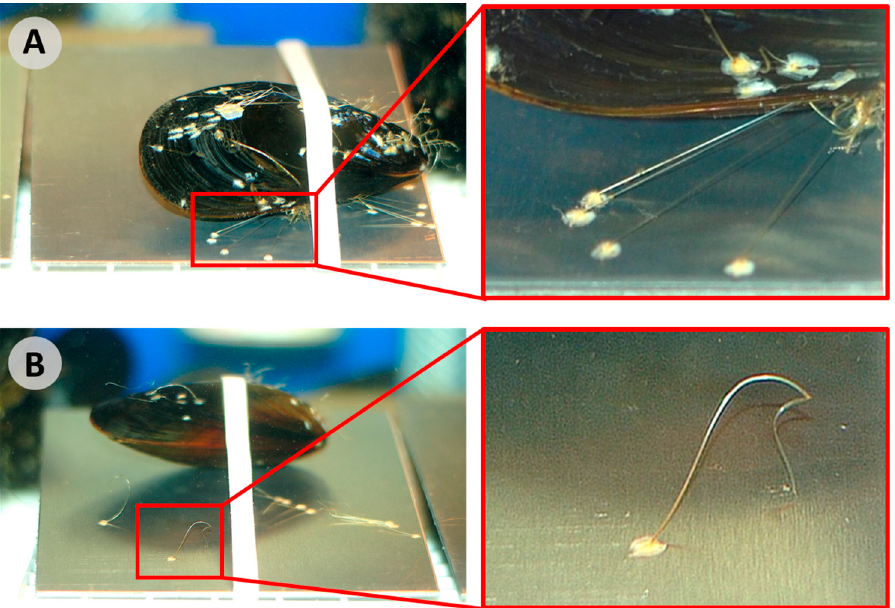
Figure 3. Experimental setup of marine mussels banded to aluminum substrates where: ( A ) Threads remain attached to the animal, taught and controlled by byssal retractor muscles; ( B ) Threads have been detached from the mussel at the closest point near their shell using a razor blade. The soft proximal portion of the threads can be seen where the threads start to curl and wave. The crystalline distal portions remain relatively straight.